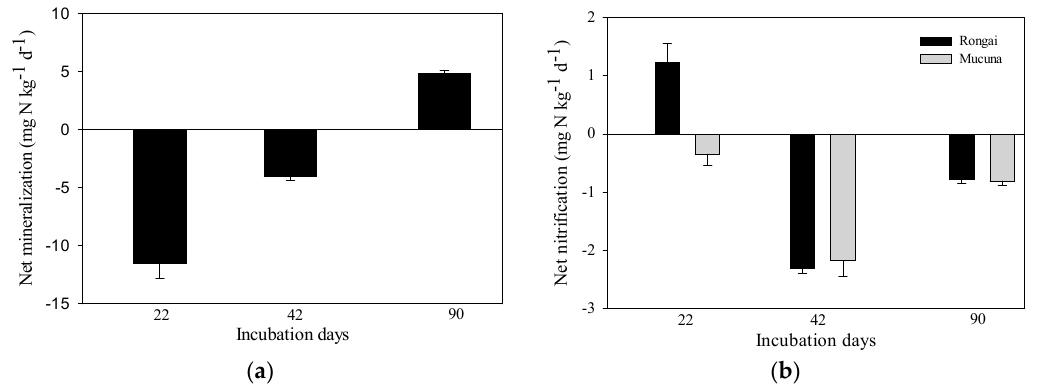
Figure 4. Average values of ( a ) N net mineralization in the soil during 90 days of incubation and ( b ) N net nitrification for the interaction of annual cover crops and incubation days. Vertical lines represent the standard errors.